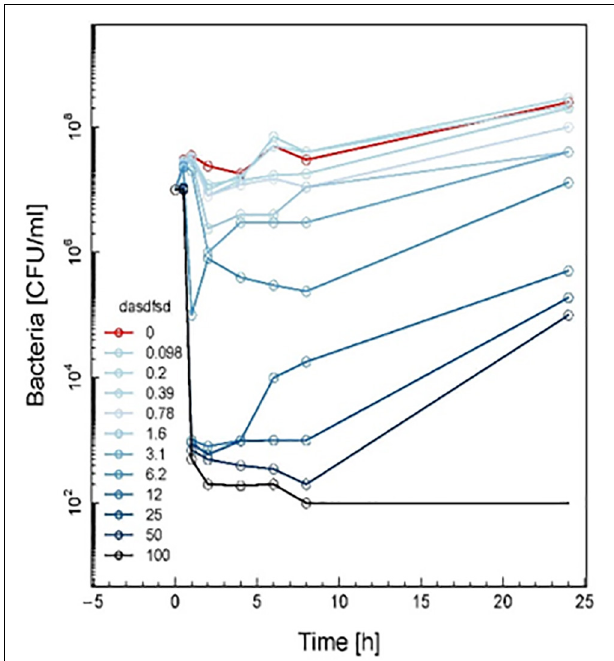
FIGURE 9 | Time-kill curve study of vancomycin versus MRSA in log-phase at drug exposure. The curve displays the mean CFU for duplicate samples and represents data from two independent experiments. Twelve doubling dilutions are plotted, the highest concentration ( black line ) corresponds to 16 × MIC. Growth in absence of antimicrobial is drawn in red . The compound was added at time point 0 and monitored until 24 h. The limit of detection in the assay was 100 CFU mL − 1 .